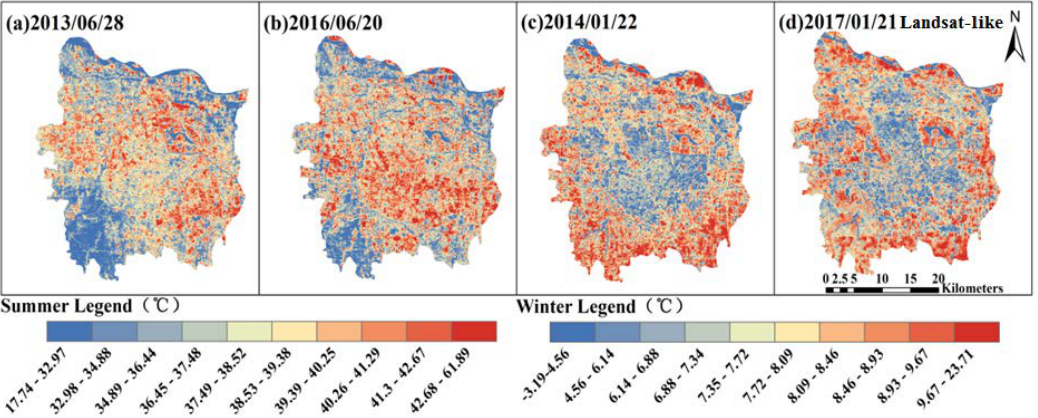
Figure 7. LST distribution in four periods.